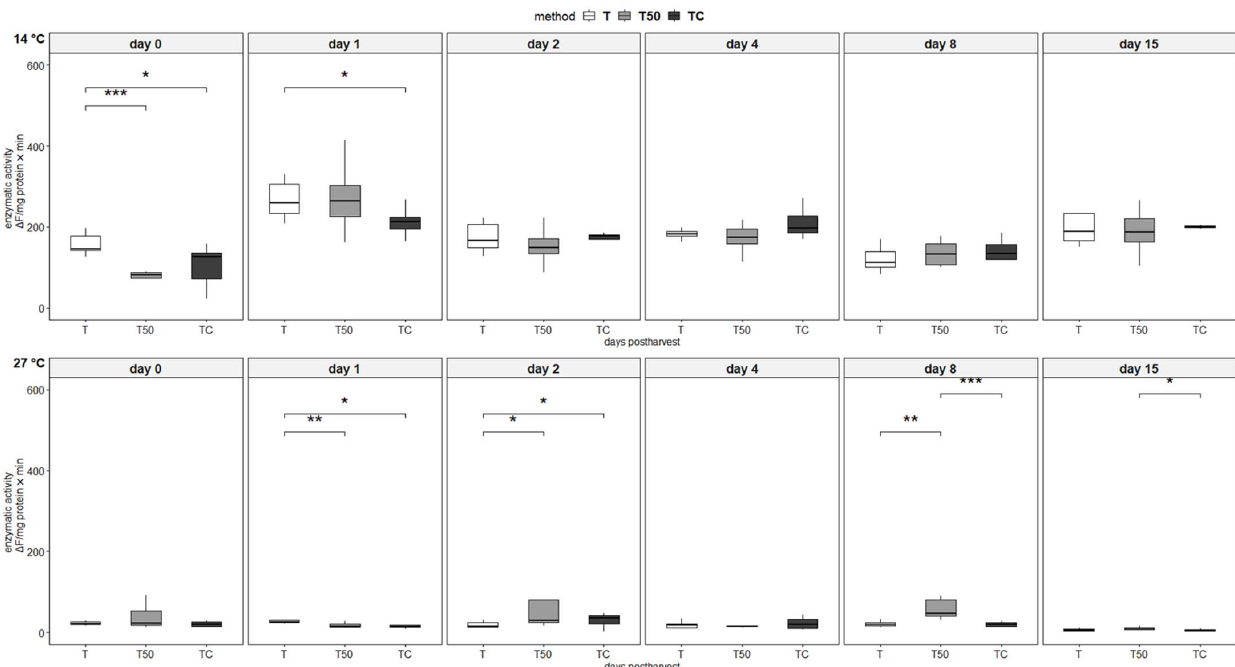
Figure 5. Calpain activity in all tested slaughter and storage conditions. T: control group, slaughter and storage in ice flakes; T50: slaughter and storage in 1:1 slurry ice to ice flakes; TC: slaughter in slurry ice, storage in ice flakes. Enzymatic activity is expressed as fluorescence unit (FLU) change per minute per mg protein (ΔF). Superscripts: statistically significant differences between treatments on each day (***: p < 0.001, ** p < 0.01, *: p < 0.05).